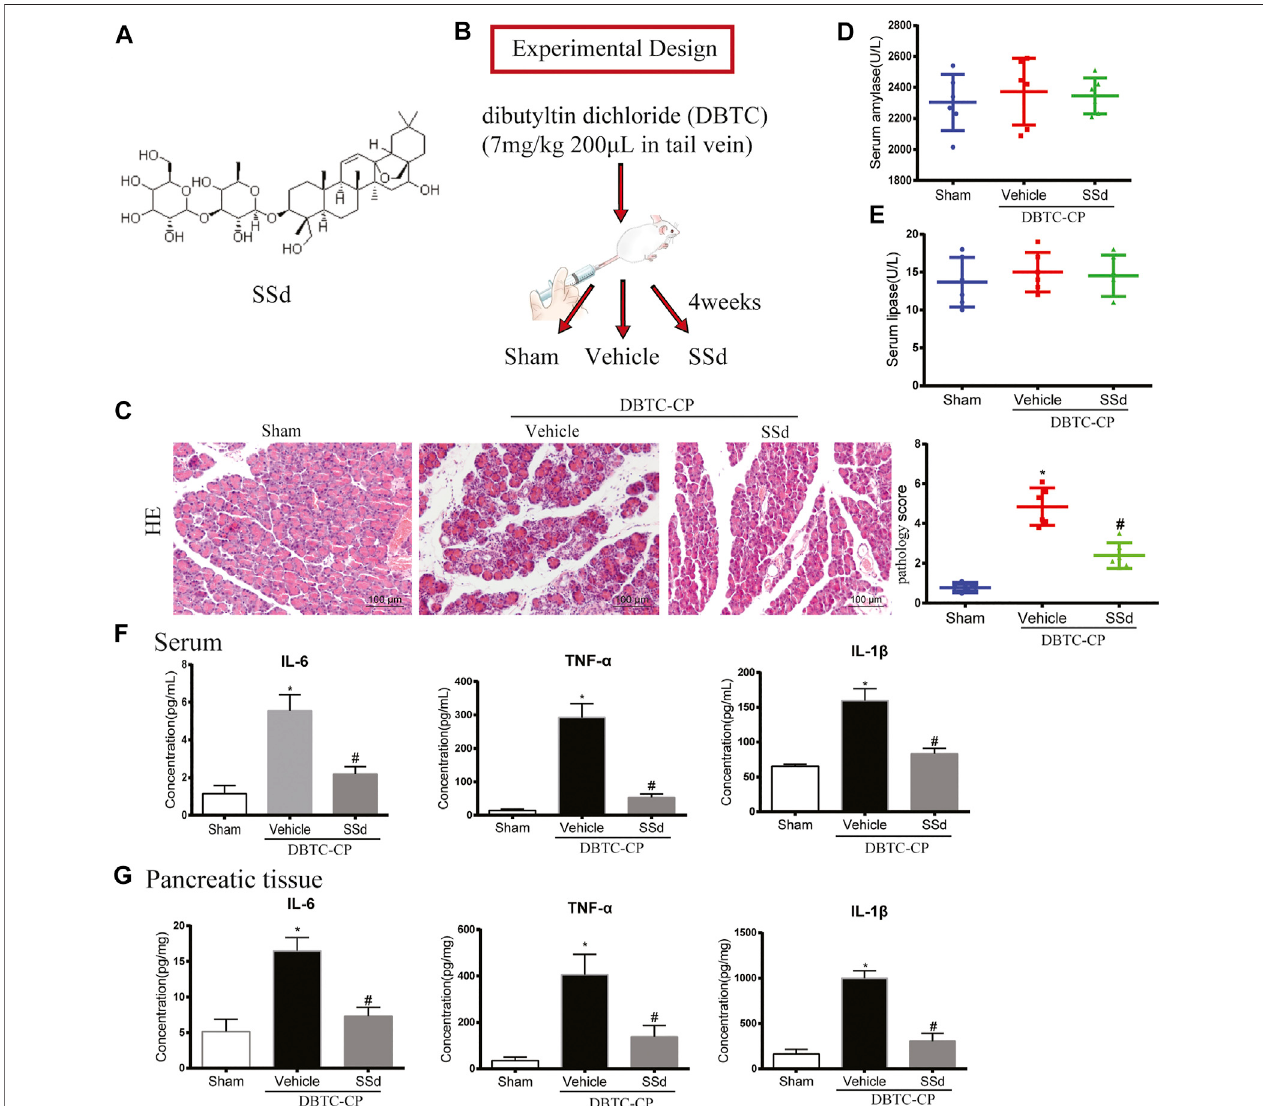
FIGURE 1 | Effects ofSSd on the histological changes, serum amylaseand lipase in DBTC-induced CP (A) The chemical structure of SSd (B) Schematic of in vivo experiment design. (C) The pathological score ofH and Estaining(original magni fi cation, × 200). (D) Serum amylaselevels. (E) Serum lipase levels. (F) The levels ofIL-6, TNF- α , and IL-1 β in serum. (G) The levels of IL-6, TNF- α , and IL-1 β in pancreatic tissue. ( n (cid:1) 6 – 8, p p < 0.05 vs. Sham group; # p < 0.05 vs. CP group).